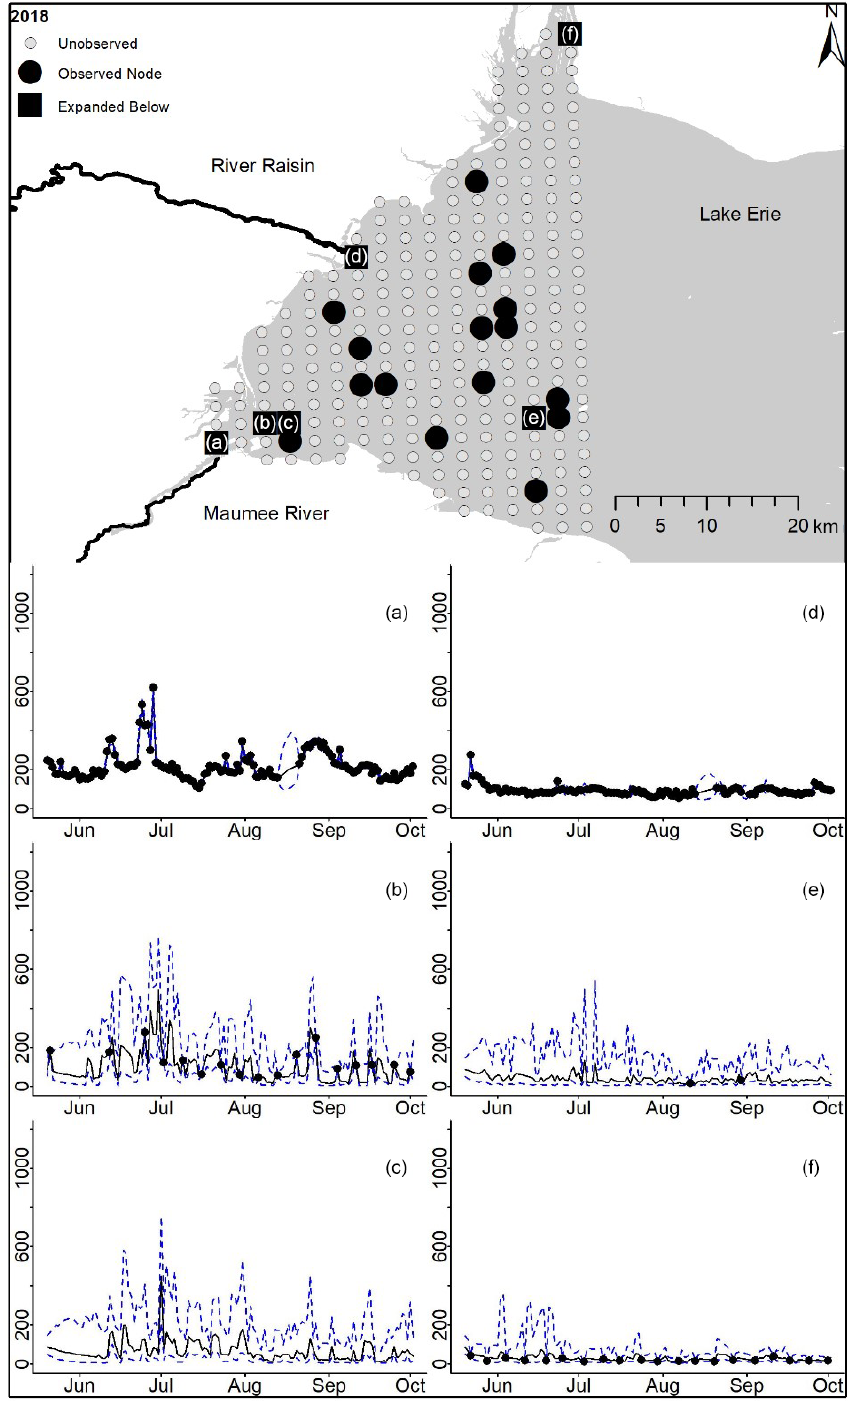
Figure 2. For 2018 the total phosphorus concentrations (µgL − 1 ) at observed and unobserved nodes were estimated from the model posterior samples. Mean (solid black line) and 95%PI (dashed blue line) for the model posterior samples of each node at every day for (a) the Maumee River, (b, c, e, f) western Lake Erie nodes, and (d) the Raisin